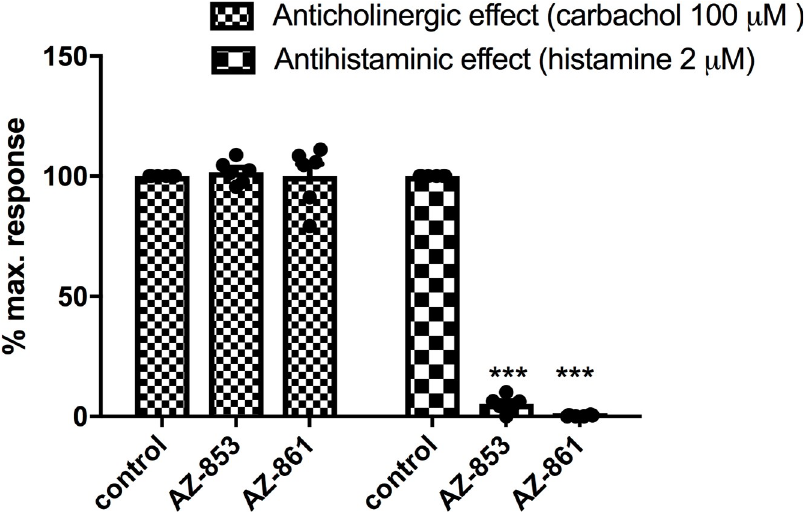
Fig 9. Effects of AZ-853 and AZ-861 on carbachol and histamine-induced smooth muscle contraction in isolated small intestine of guinea pig. All values represent the mean ± SEM, n = 6. Statistical analysis was performed using Student’s t-test; ��� p < 0.001 vs. control.